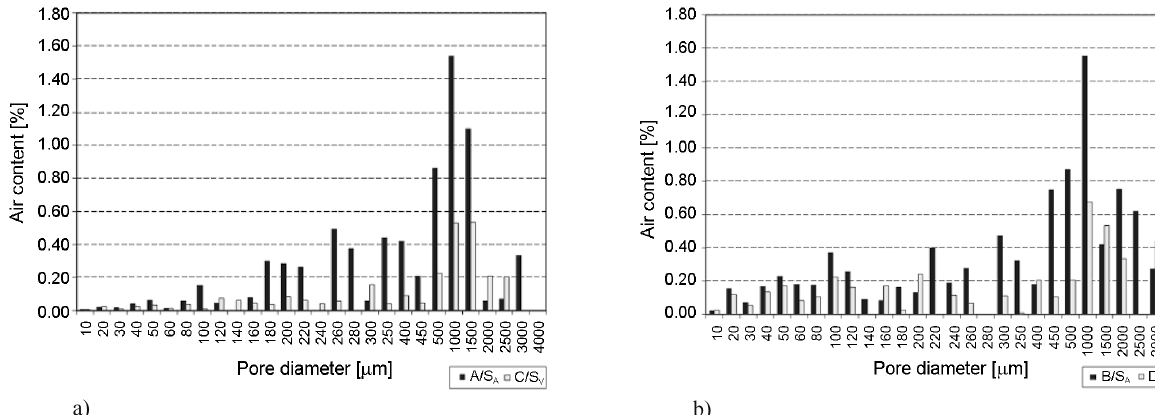
Fig. 4. Air pore content distribution depending on pore diameter in concretes: a) A/S A and C/S V ; b) B/S A and D/S V